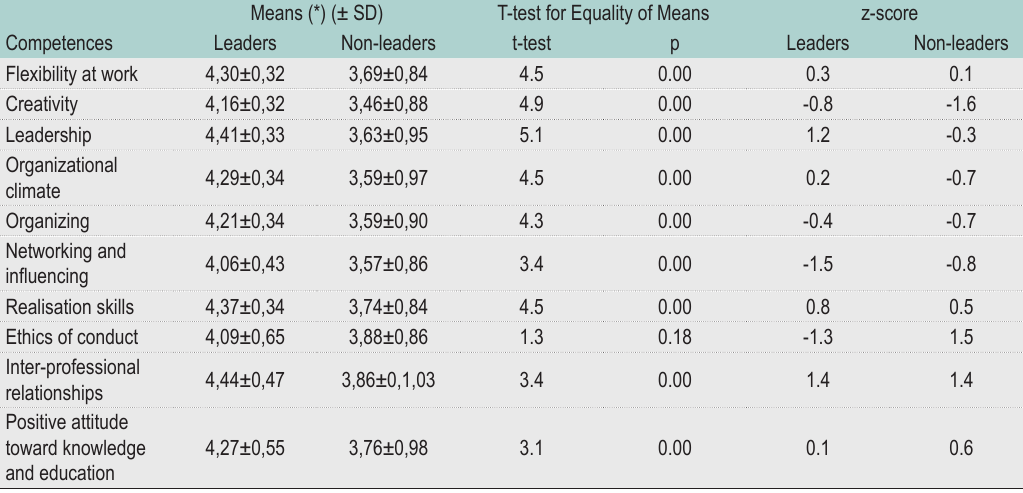
(*) Attributed grades: 1 – completely atypical action/behaviour; 5- decisive